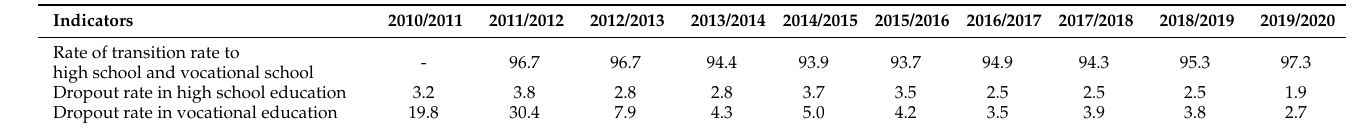
Table 2. The evolution of transition rates and of school dropout rates for high school and